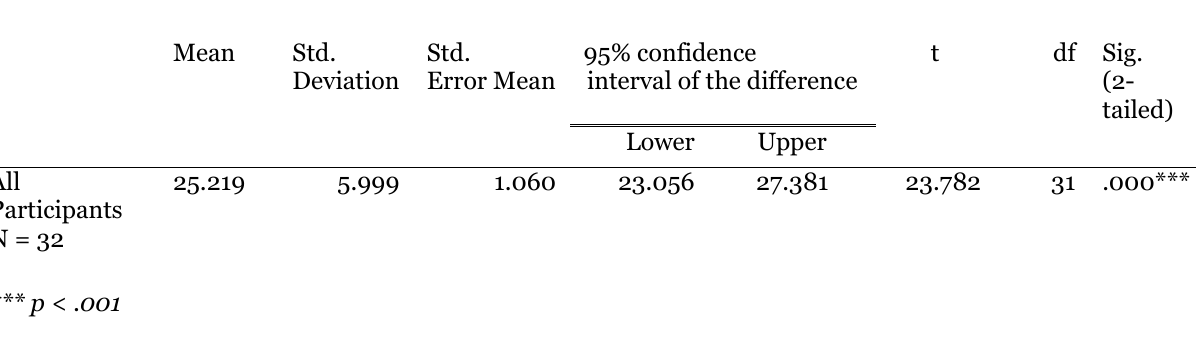
Difference in the Frequencies of Strategy Use Mean